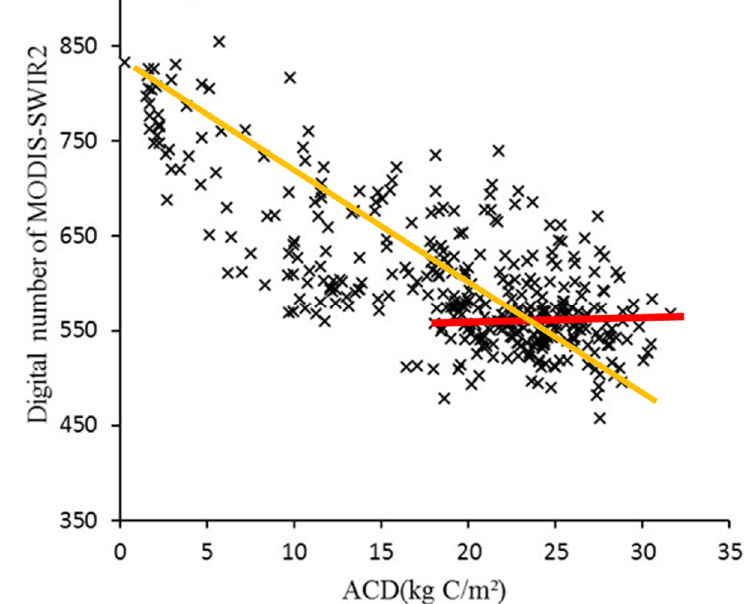
Figure 7. The relationship between spectral values of SWIR2 and aboveground carbon density (ACD), showing the data saturation problem. The symbol " × " shows the samples used for establishing the relationships between ACD and the SWIR2 band; yellow line shows the negative linear trend, that is, the SWIR2 values decrease as ACD values increase; red line shows that even ACD values increase, SWIR2 values do not show obvious change, meaning the data saturation problem in the MODIS data.